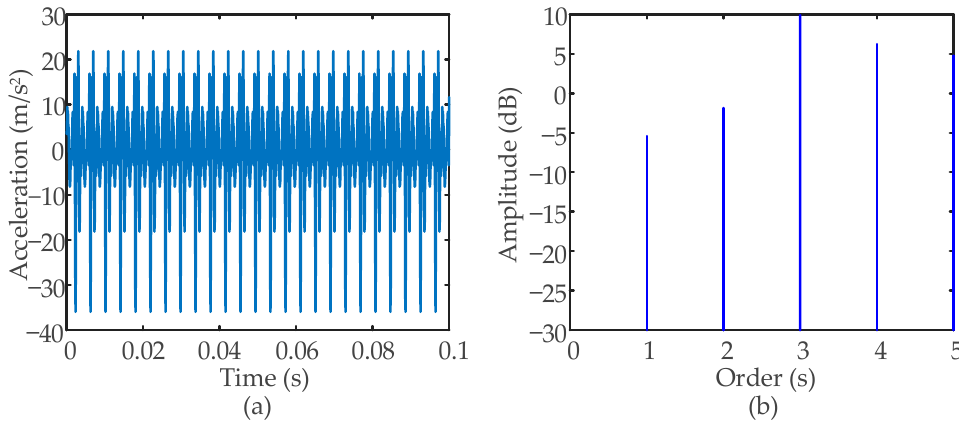
Figure 18. Health condition: ( a ) Time-domain waveform; ( b ) Amplitude spectrum.